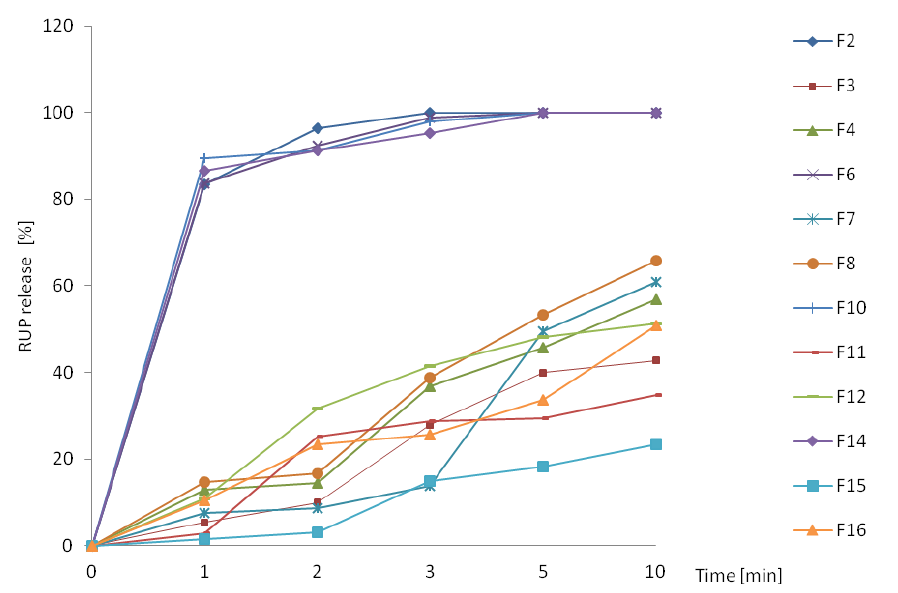
Figure 5. RUP release from designed ODMT performed in paddle apparatus.